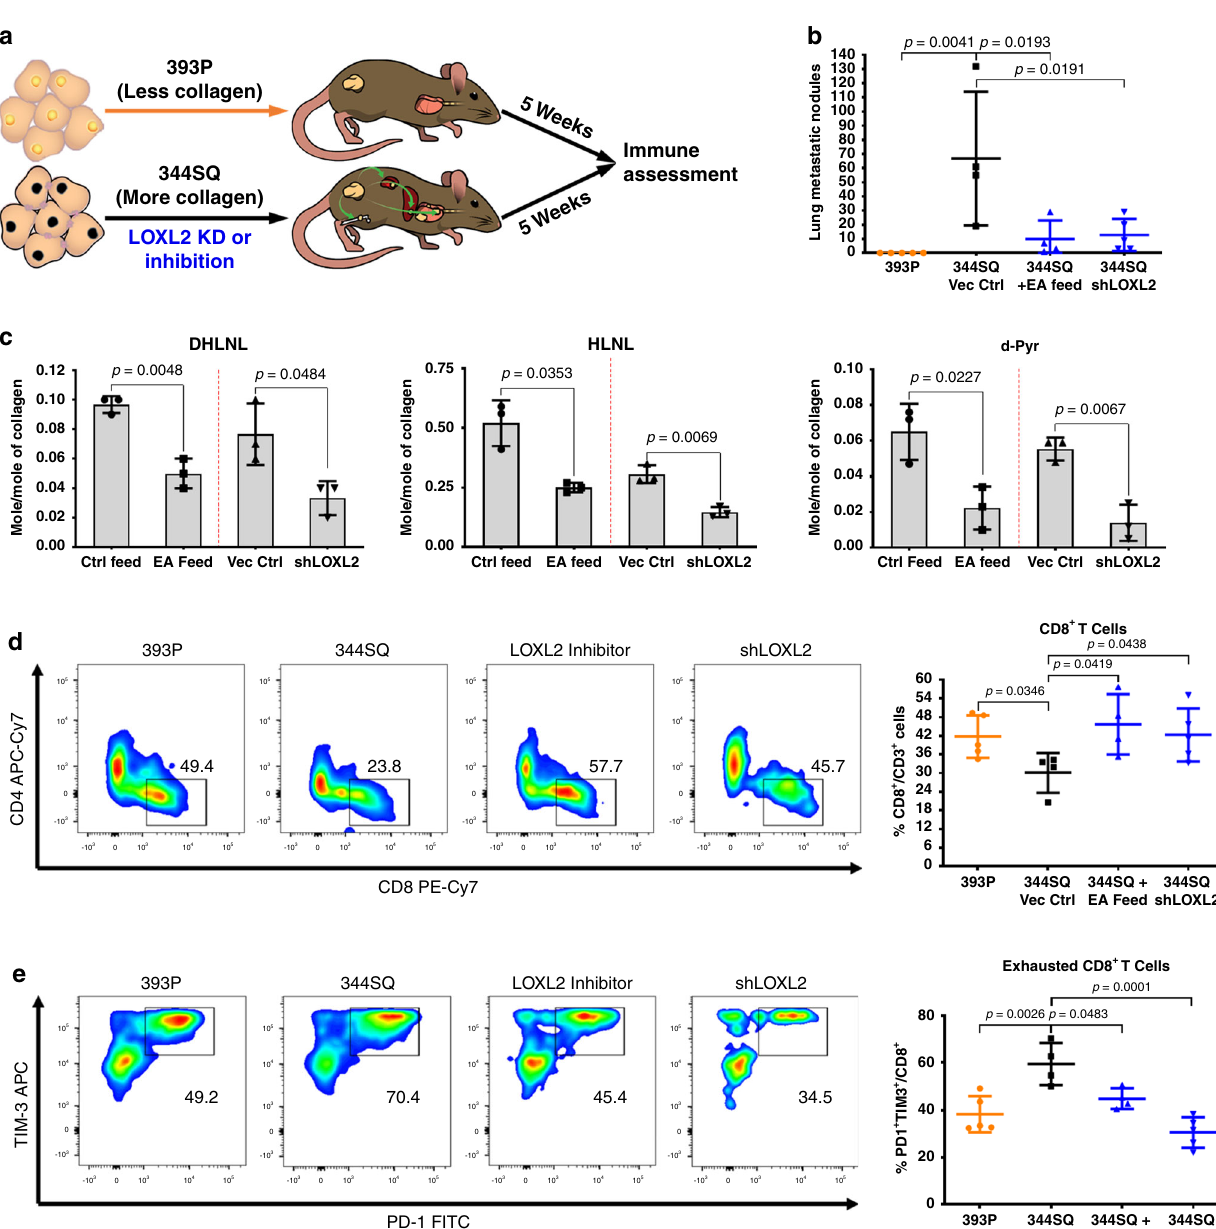
Fig. 2 Tumors with decreased collagen have increased CD8 + TILs and decreased exhausted CD8 + TILs. a Experimental schema illustrating immune assessment of 393P or 344SQ KP syngeneic tumors with LOXL2 knockdown or enzymatic inhibition. Tumors were collected and analyzed 5 weeks following subcutaneous implantation. Ellagic acid LOXL2 inhibitor was administered through mice feed 1-week following tumor implantation. b Quanti fi cation of lung metastatic surface nodules for indicated tumor groups after 5 weeks of tumor growth; 393P and 344SQ-shLOXL2 n = 5 mice per group; 344SQ Vec Ctrl and EA feed n = 4 mice per group. c Ratio of moles of DHLNL, HLNL, and d-Pyr collagen crosslinks per mole of total collagen analyzed by mass spectrometry in 344SQ tumors treated with EA feed LOXL2 inhibitor or LOXL2 shRNA; n = 3 tumors per treatment group. Data presented as mean + / − SD. Statistics calculated as a two-tailed student ’ s t -test between different two groups from two separate experiments as denoted by a dashed-red line. d Left: Representative FACS plots of indicated tumor cell suspensions for percentage of CD8 + T cells gated from CD45 + CD3 + cells. Right: Quanti fi cation of percentage of total CD8 + T cells for each individual tumor sample; 393P and 344SQ-shLOXL2 n = 5 mice per group; 344SQ Vec Ctrl and EA feed n = 4 mice per group. e Left: Representative FACS plots of indicated tumor cell suspensions for percentage of PD-1 + TIM-3 + cells gated from CD8 + T cells in ( d ). Right: Quanti fi cation of percentage of PD-1 + TIM-3 + CD8 + T cells for each individual tumor sample; 393P and 344SQ-shLOXL2 n = 5 mice per group; 344SQ Vec Ctrl and EA feed n = 4 mice per group. All data presented as mean + / − SD. Statistics calculated using a one-way ANOVA post hoc Tukey 344SQ tumors reduced metastatic disease (Fig. 2b), collagen gating strategy of 344SQ tumors shown in Supplementary Fig. 3) crosslinking (Fig. 2c), and collagen deposition (Supplementary revealed that LOXL2 inhibition or knockdown increased tumor- Fig. 2c and d) with no signi fi cant effect on primary tumor growth in fi ltrating CD8 + T cells and decreased PD-1 + TIM-3 + exhausted (Supplementary Fig. 2e). Flow cytometry analysis (sample fl ow CD8 + T cells (Fig. 2d and e), comparable to 393P tumors with